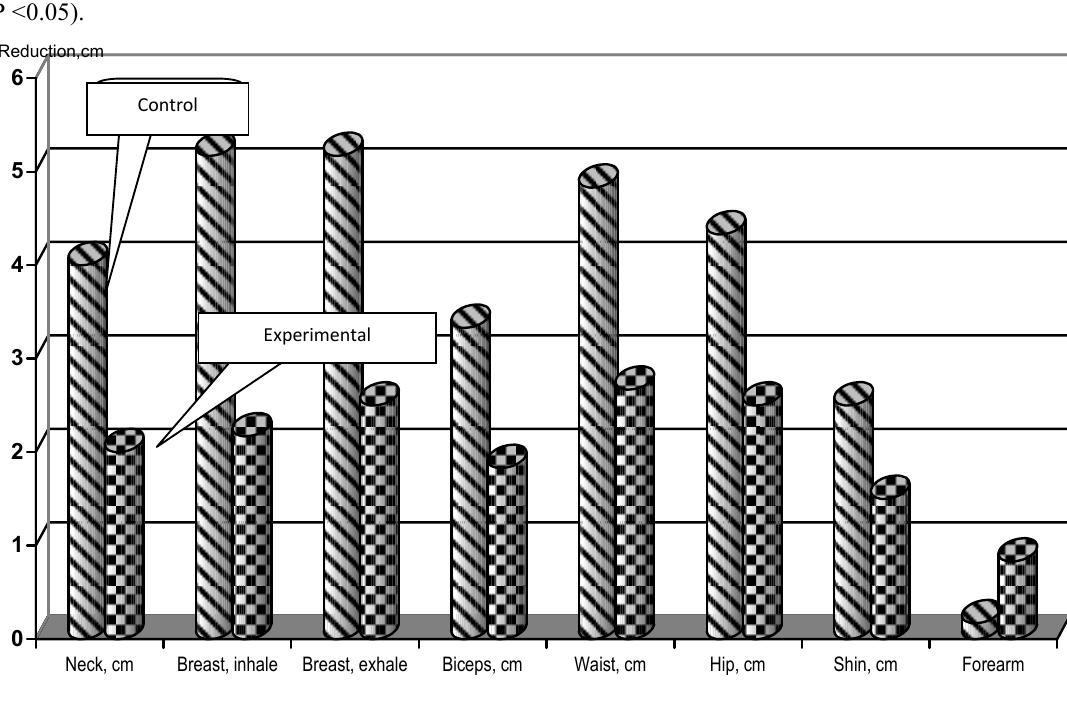
Fig.1. Comparative diagram of increment of anthropometric data of qualified bodybuilders (control and experimental groups) on competition